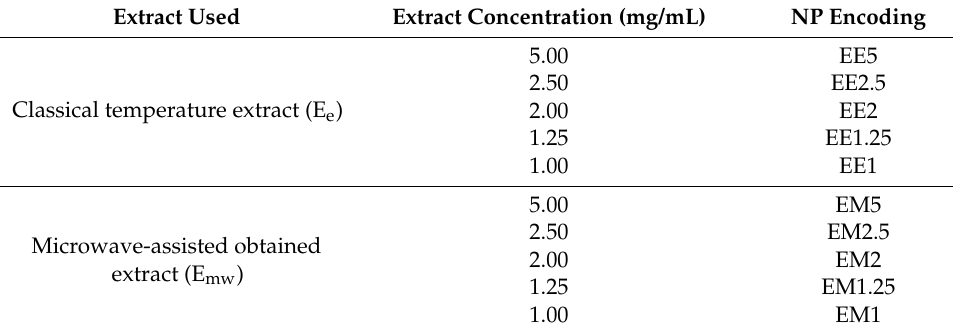
Microwave-assisted obtained extract (E mw